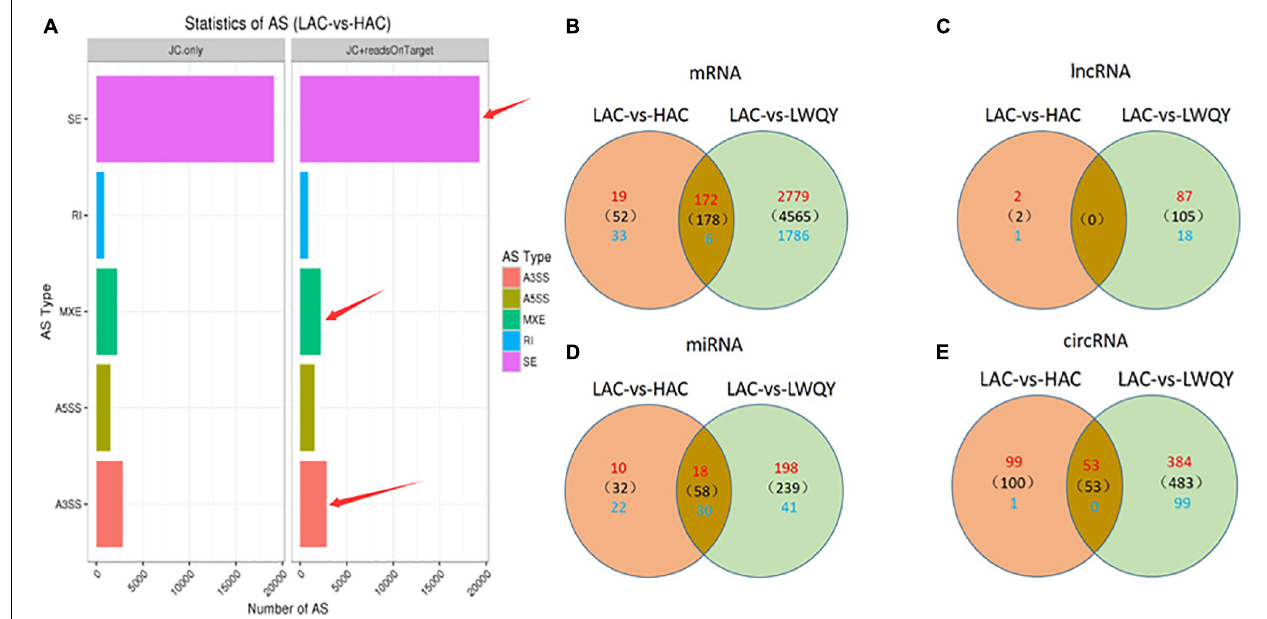
FIGURE 1 | The distribution of alternative splicing events in the HAC and LAC groups (A) , and the differentially expressed mRNA transcripts (B) , lncRNA transcripts (C) , miRNA transcripts (D) , and circRNA transcripts (E) in the LAC-vs-LWQY and LAC-vs-HAC comparison groups. “SE” is short for “skipped exon,” “A3SS” is short for “alternative 3 (cid:48) splice site,” “A5SS” is short for “alternative 5 (cid:48) splice site,” “MXE” is short for “mutually exclusive exon,” “RI” is short for “retained intron,” “HAC” is short for “high-altitude cattle,” “LAC” is short for “low-altitude cattle,” “LWQY” is short for “LeiRoqi yak.”